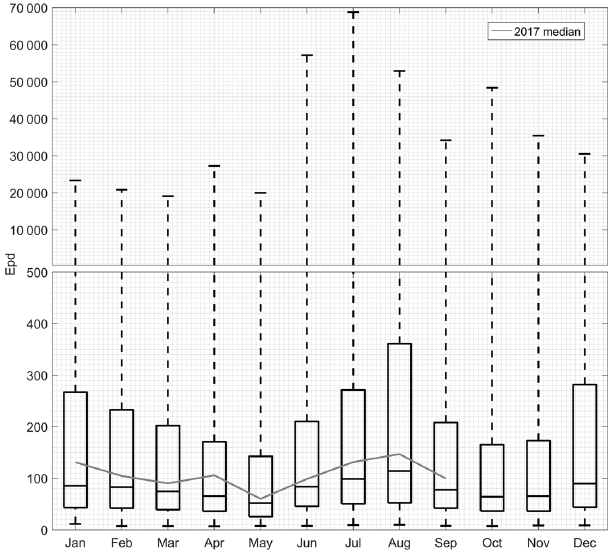
Figure 4. Monthly distributions of daily energy (GJ) released per pixel during the calibration period (2004–2016). Monthly values of the median are indicated by the horizontal line inside each box, the first and third quartiles are indicated by the bottom and top sides of the box, respectively, and the maximum and minimum val- ues by the whiskers. The superimposed grey curve shows the val- ues of the monthly medians during the validation period (January– September